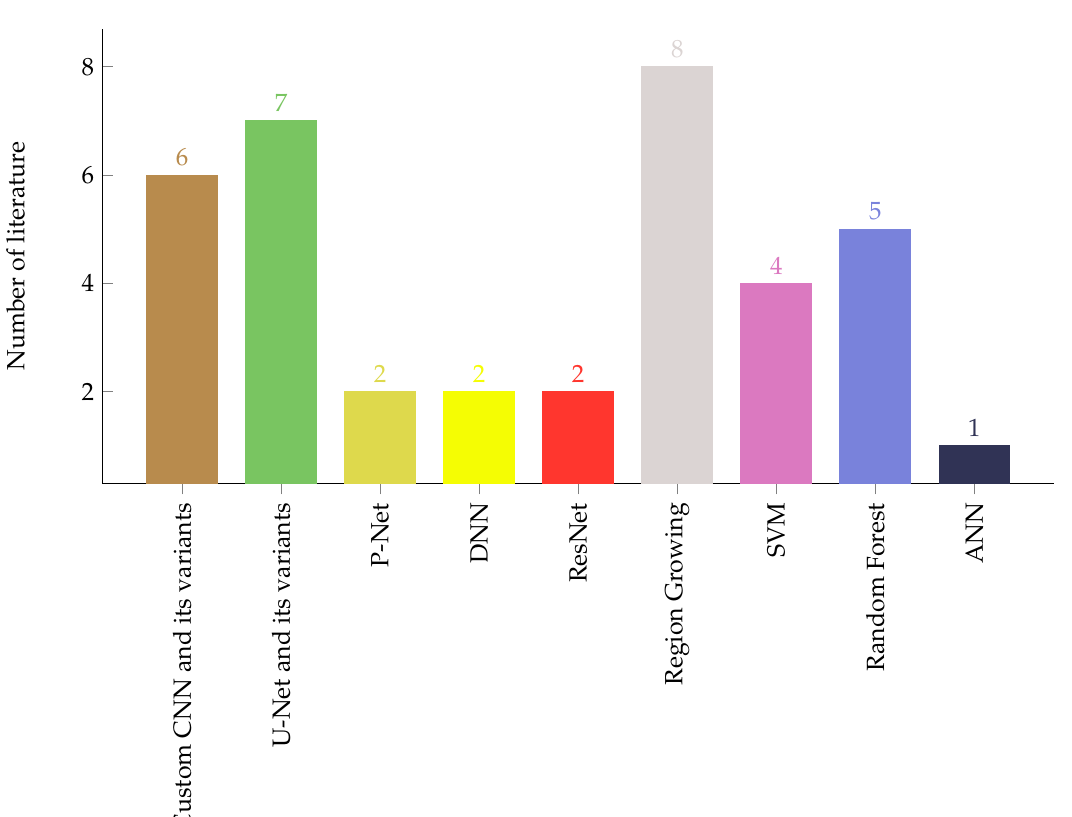
Figure 1. Number of brain tumor segmentation